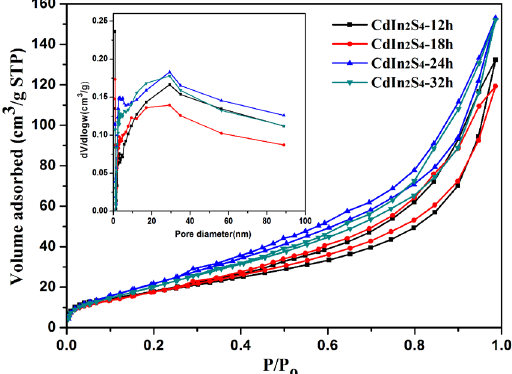
Figure 8. Nitrogen adsorption-desorption isotherms and corresponding pore-size distribution curves (inset) of the CdIn